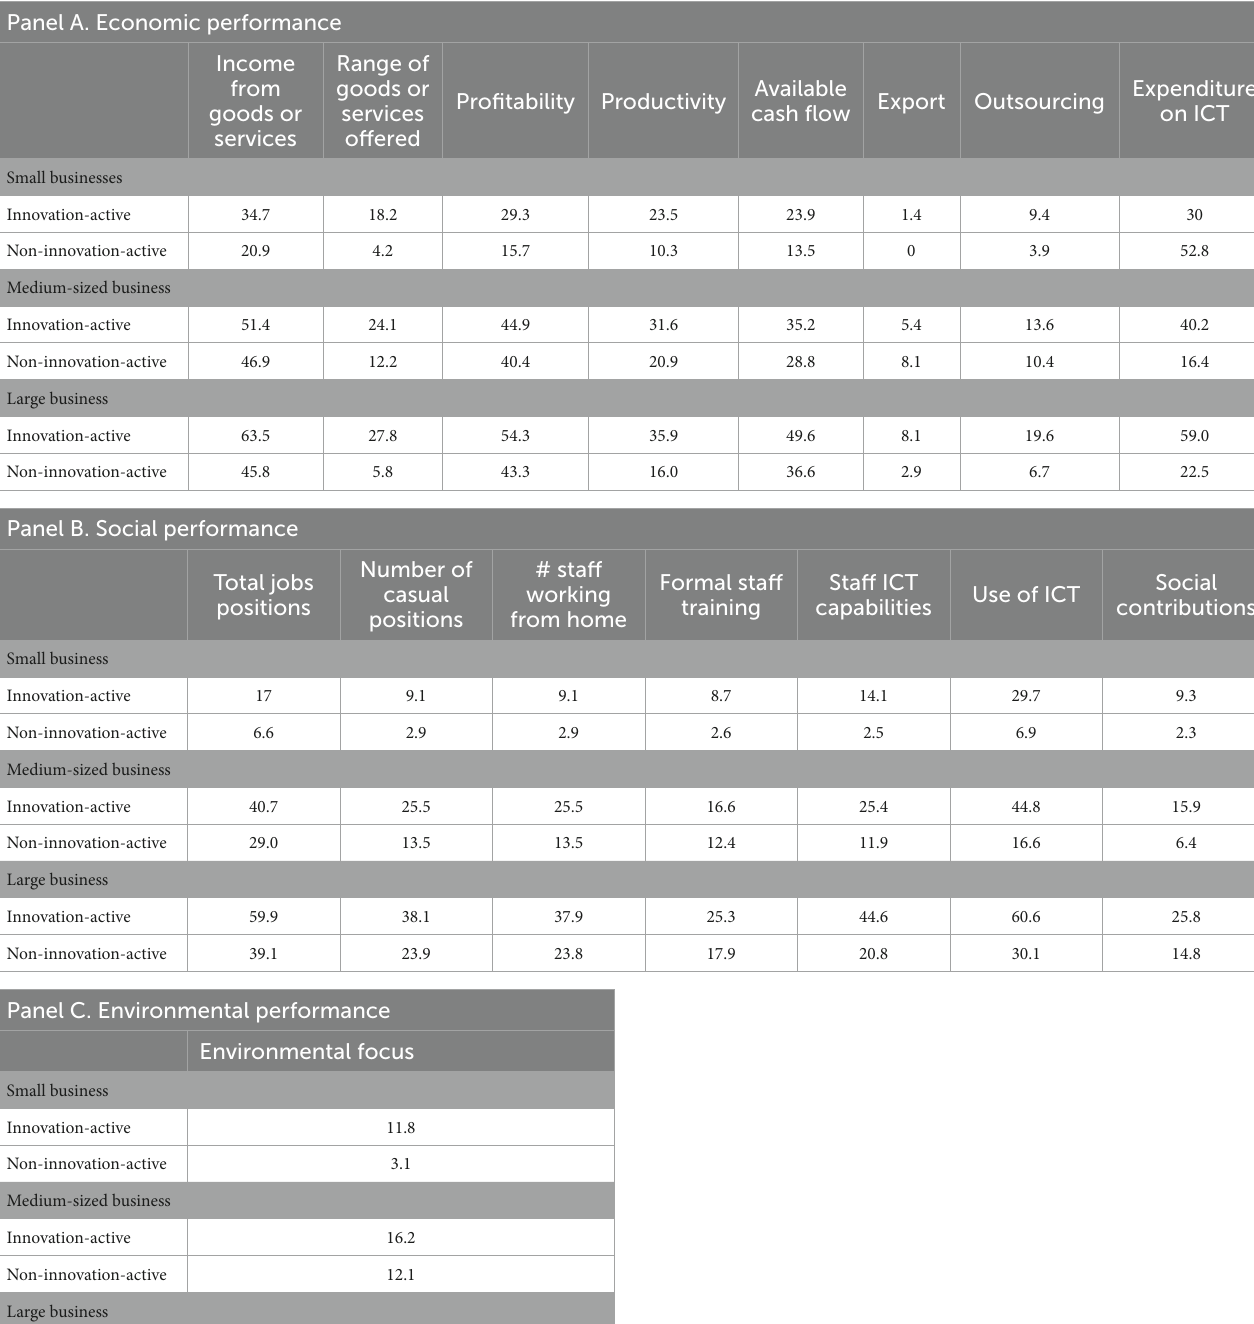
TABLE 1 Percentage of businesses with increases in performance in innovation-active and non-innovation-active businesses. Panel A. Economic